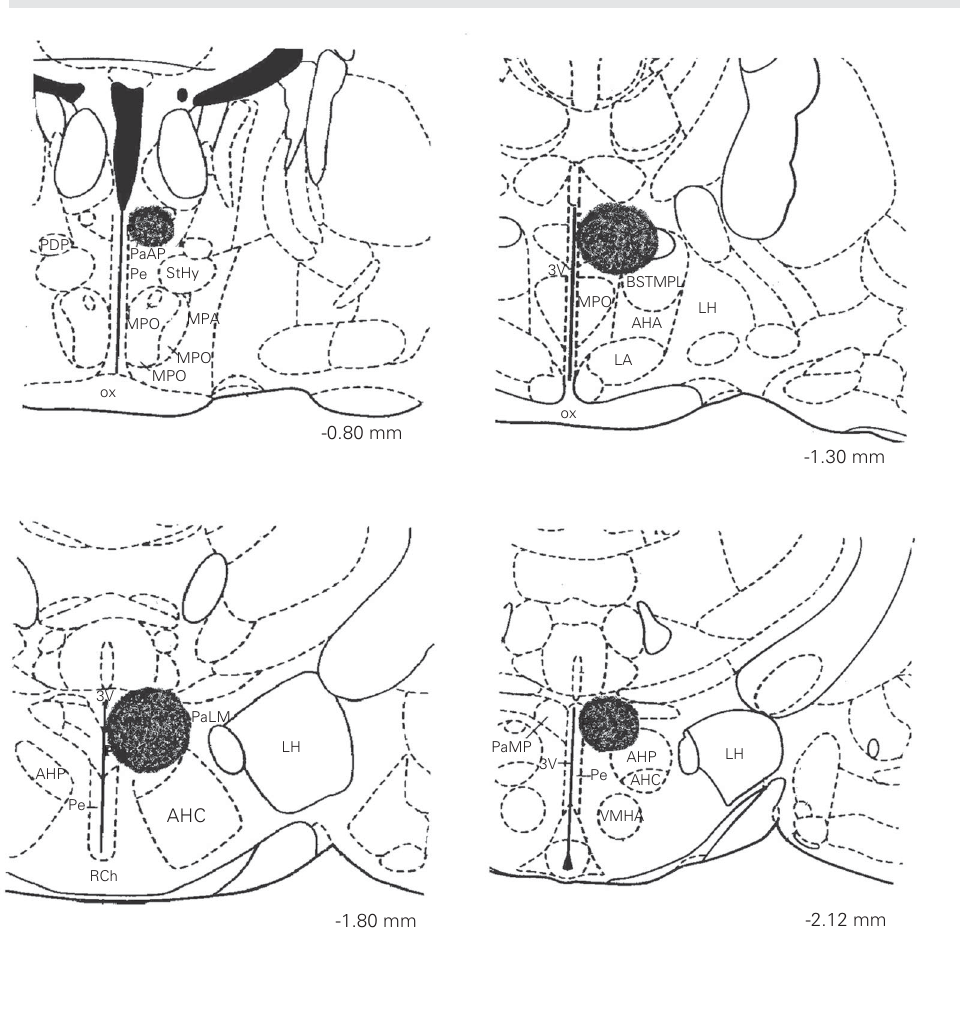
Figure 4. Top four panels are schematic presentations of the location of the electrolytic lesion in the hypothalamus. The numbers below each scheme indicate the rostrocaudal distance from the bregma. 3V = 3rd ventricle; AHA = anterior hypothalamic area, anterior part; AHC = anterior hypothalamic area, central part; AHP = anterior hypotha- lamic area, posterior part; BSTMPL = bed nucleus of stria terminalis, medial division, posterolateral part; LA = lateroanterior hypothalamic nucleus; LH = lateral hypothalamic area; MPA = medial preoptic area; MPO = medial preoptic nucleus; ox = optic chiasm; PaAP = paraventricular hypothalamic nucleus, anterior parvicellular part; PaLM = para- ventricular hypothalamic nucleus, lateral magnocellular part; PaMP = paraventricular hypothalamic nucleus, medial parvicellular part; PDP = posterodorsal preoptic nucleus; Pe = periventricular hypothalamic nucleus; RCh = retrochiasmatic area; StHy = striohy- pothalamic nucleus; VMHA = ventromedial hypothalamic nucleus, anterior part. The graph represents the gastric retention (%), reported as mean ± SEM, of a saline test solution 10 min after administration by gavage to the rats. Ten days before the procedure the animals were submitted to sham surgery (Sham) or to bilateral electro- lytic lesion of the paraventricular nucleus of the hypothalamus (PVNX). The animals in the Naive group were not submitted to any intervention. Thirty minutes before evalua- tion of gastric emptying, the animals received vehicle (C) or 80 mg/kg dipyrone (Dp) iv . The number of animals is given in parentheses. *P < 0.01 for the comparisons indicated by the arrows (Tukey